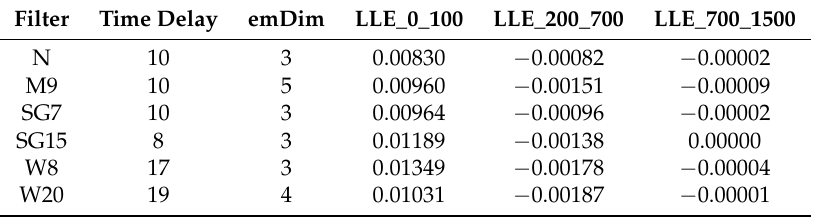
Figure 6. Example phase space plots (orbits) for time series presented in Figure 4. An orbit consists of all points y ( i ) representing system states. Coordinates of y ( i ) are calculated from scalar measurements o ( i ) , according to the formula presented in Equation (1). The axes represent coordinates of the first three dimensions of y ( i ) : o ( i ) , o ( i + τ ) , o ( i + 2 τ ) . Table 4. Results obtained for the time series presented in Figure 6 during the underlying dynamics